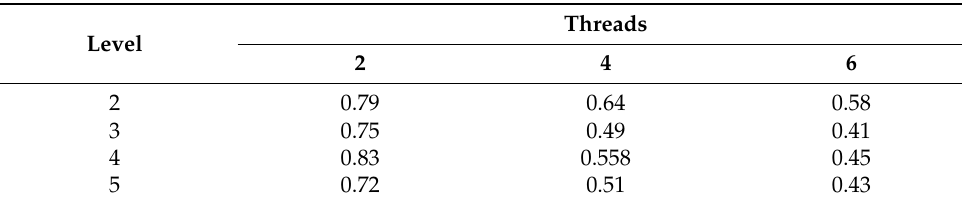
Table 11. Efficiency of parallel V cycle of AGAMG in combination with deflation technique and MGenFAspI with droptol = 0 and l fill = 2 for 3D Poisson model problem with nx = 70.